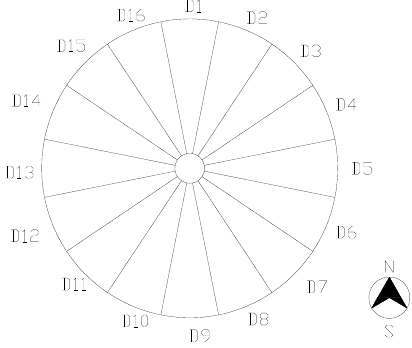
Figure 13. Definition of wind direction azimuth.